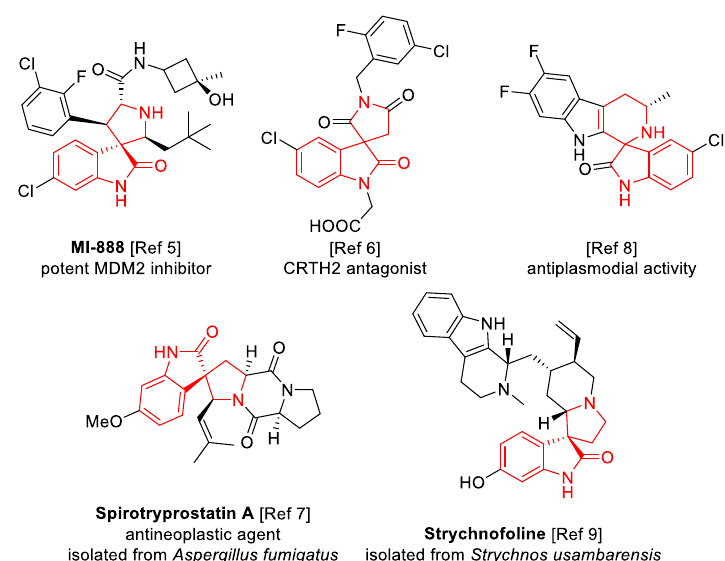
Figure 1. Selected biologically active compounds possessing a spirooxindole scaffold.